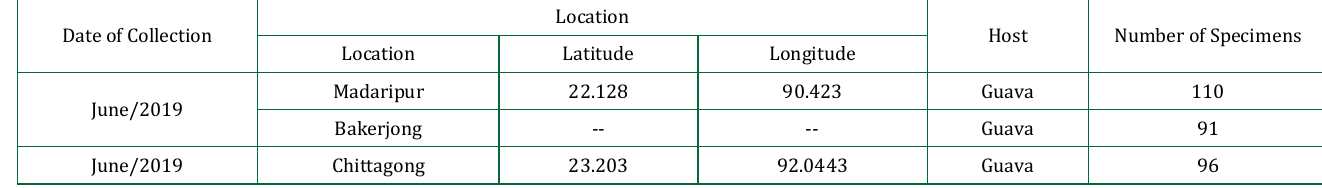
Table 3: Collection Information of Larvae Samples from Bangladesh in This